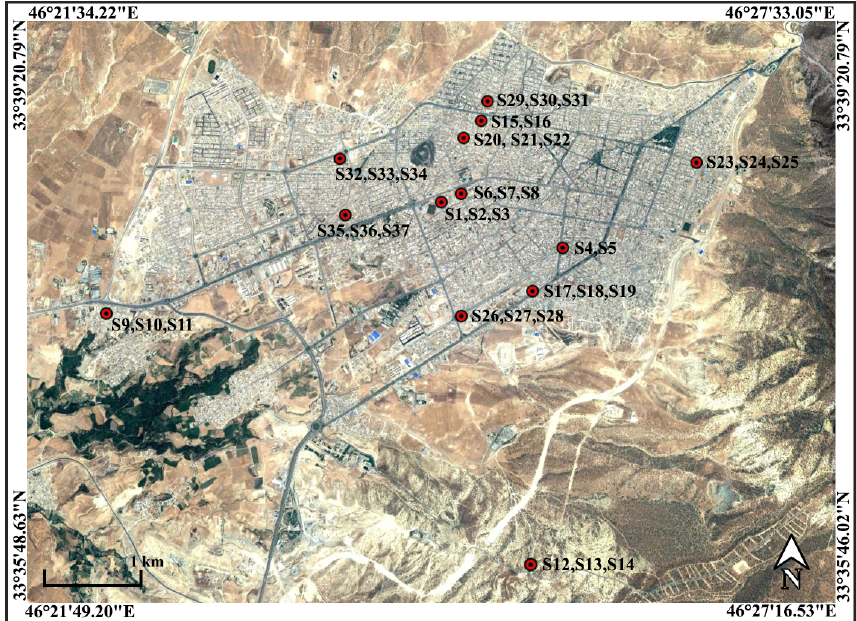
Figure 1. Map (© Google Earth) shows the distribution of samplers throughout Ilam. Annotations note sample numbers identified in Ap- pendix A, Table A1. Latitudes and longitudes are the coordinates for the corners of the